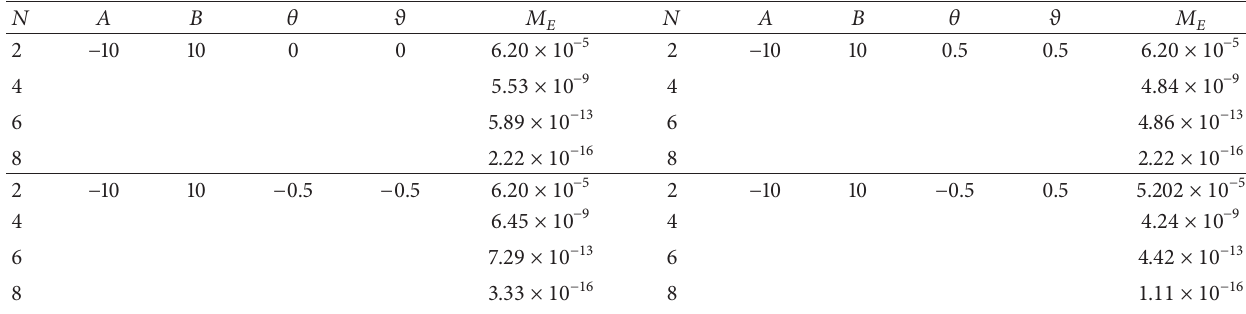
Table 3: Maximum absolute errors with various choices of 𝑁, 𝜃 , and 𝜗 with 𝜏 = 0.5 , 𝜆 1 = 0.01 , and 𝑠 = 3 for Example 3.